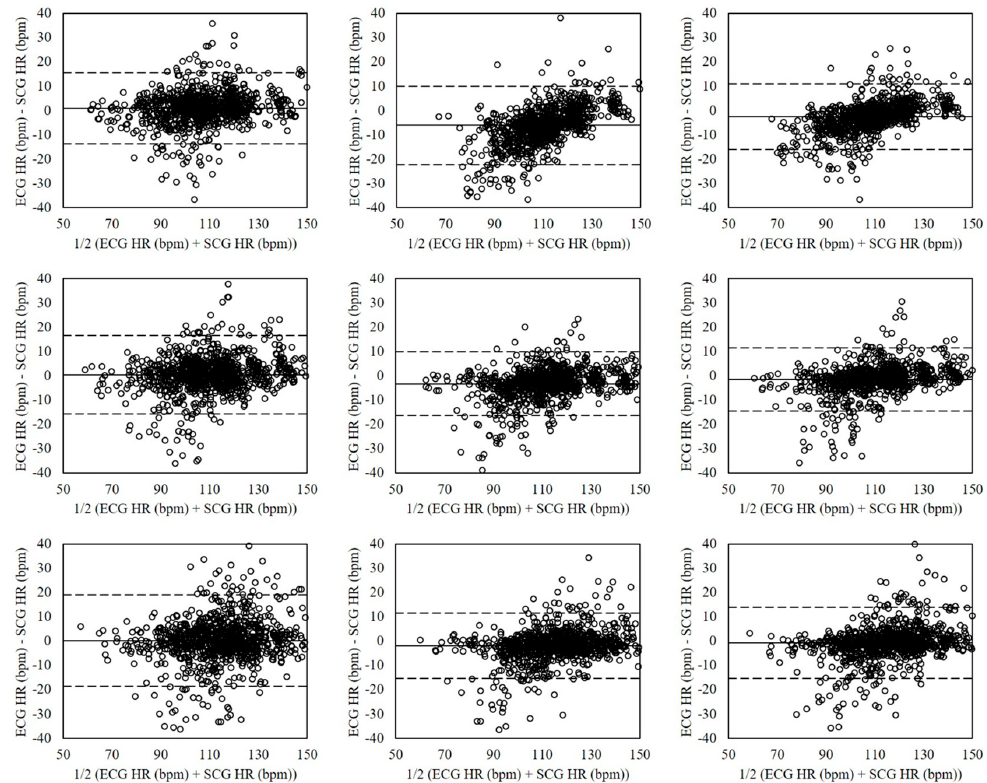
Figure 9. Bland-Altman plots of heart rates estimated from SCG and ECG by CNNs for walking at movement speeds of 3.2 ( Left ), 4.5 ( Mid ), and 5.8 ( Right ) km/h based on the VGG-16 without data augmentation ( Top ), VGG-19 with data augmentation ( Mid ), and ensemble network ( Down ). The lines are the mean errors and 95% LOA.